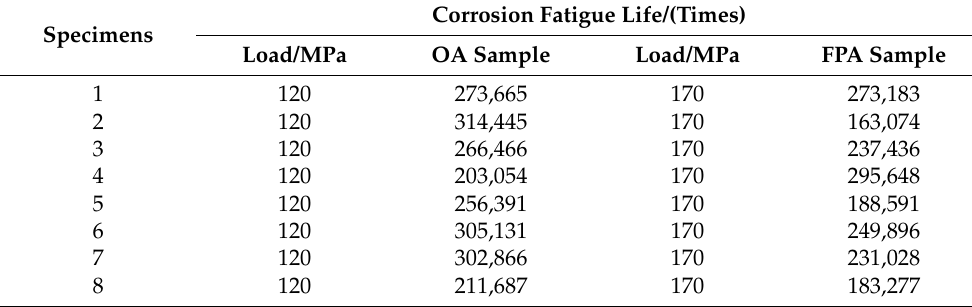
Table 4. Fatigue life of specimens in atmospheric environment.